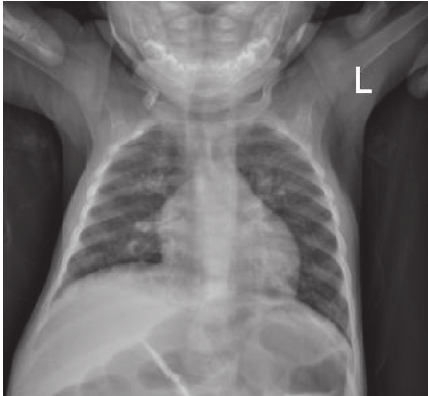
Figure 1: Chest x-ray of the